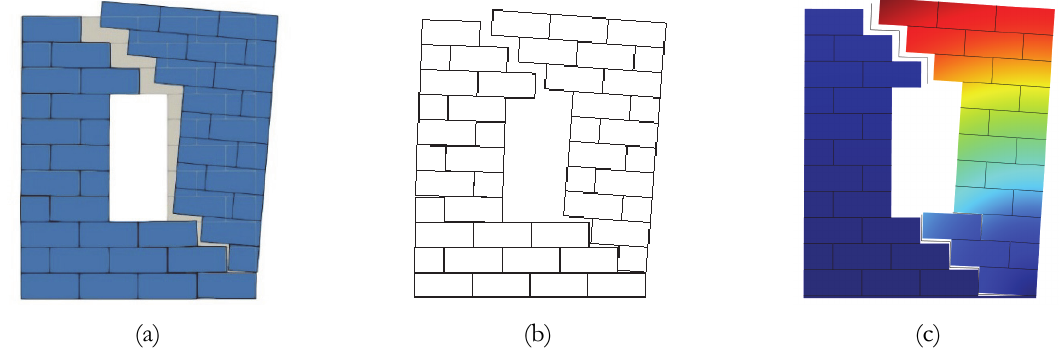
Figure 6: Collapse mechanism for Example 3, horizontal live load: ( a ) ALMA 2.0, ( 𝑏 ) FEM/DEM, ( 𝑐 ) FEM